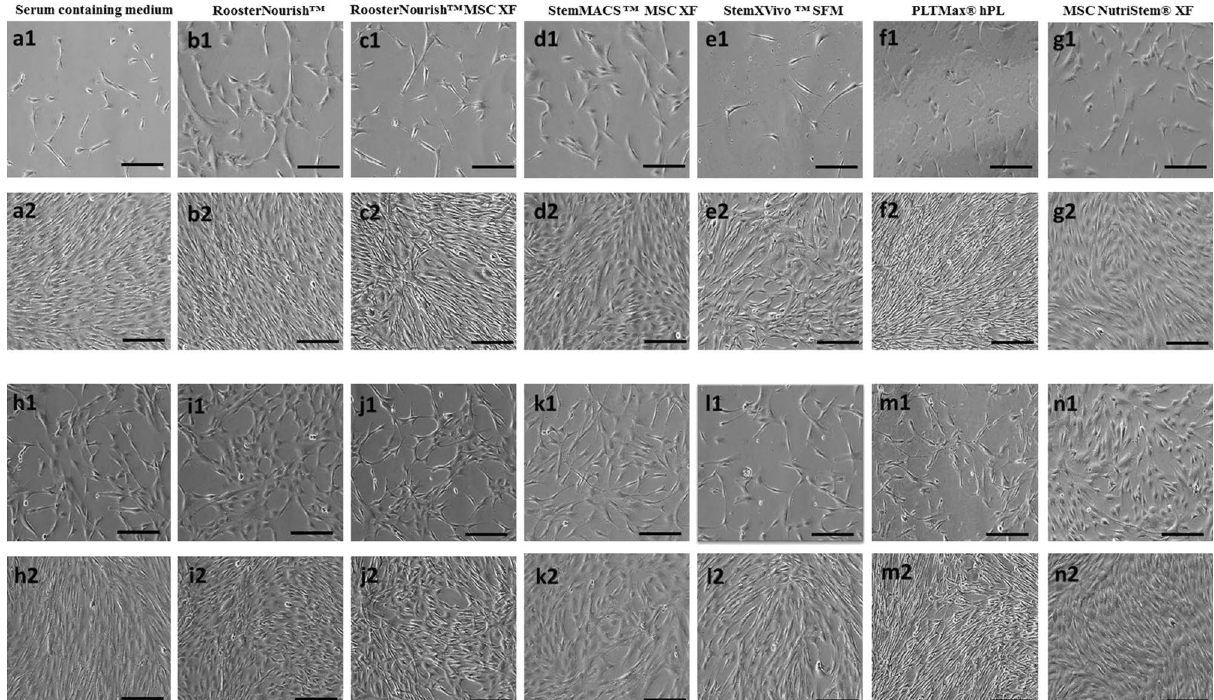
Figure 1. Morphology of BM-MSCs cultured at P4 stage. ( a1 , a2 , h1 , h2 ) BM-MSCs cultured in DMEM-KO + 10% FBS at a seeding density of 1000 cells/cm 2 ( a1 , a2 ) and 5000 cells/ cm 2 ( h1 , h2 ). ( a1 ) Microphotographs at 10–20% confluency, a2: 80–90% confluency, ( h1 ): 50–55% confluency and ( h2 ): 80–90% confluency. Similarly ( b1, b2, i1, i2 ) BM-MSCs cultured in RoosterNourish. c1, c2, j1, j2 - BM-MSCs cultured in RoosterNourish-MSC XF. d1, d2, k1, k2 - BM-MSCs cultured in StemMACS-MSC XF. ( e1, e2, i1, i2 ) BM-MSCs cultured in StemXVivo serum-free media. f1, f2, m1, m2 - BM-MSCs cultured in PLTMax human platelet lysate.